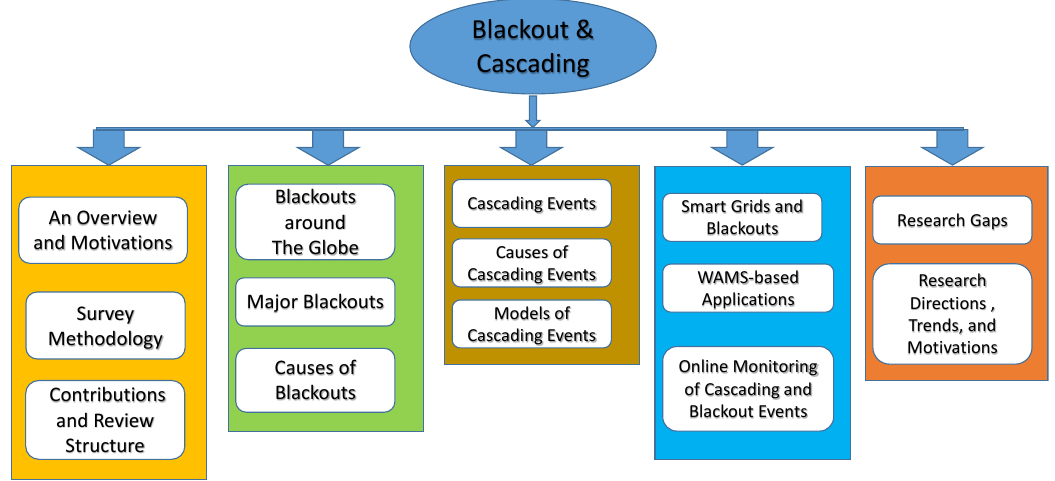
Figure 2. State-of-the-art flow chart of power systems blackout and cascading events: motivations and